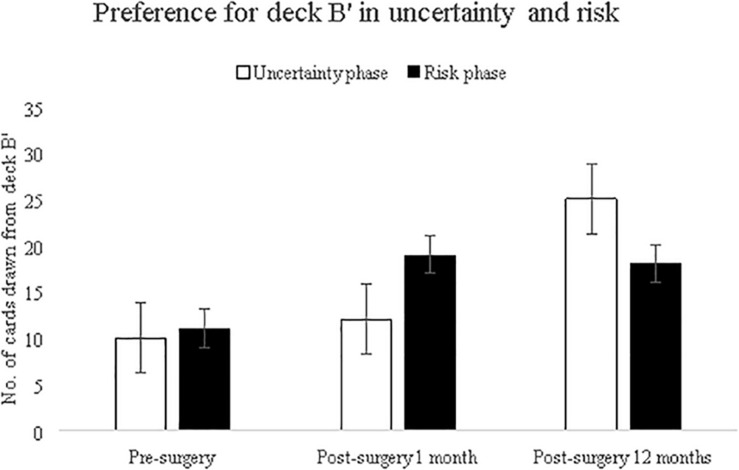
Number of cards drawn from infrequent punishment deck B′ during uncertainty and risk trials before and after surgery. Error bars show the standard error.